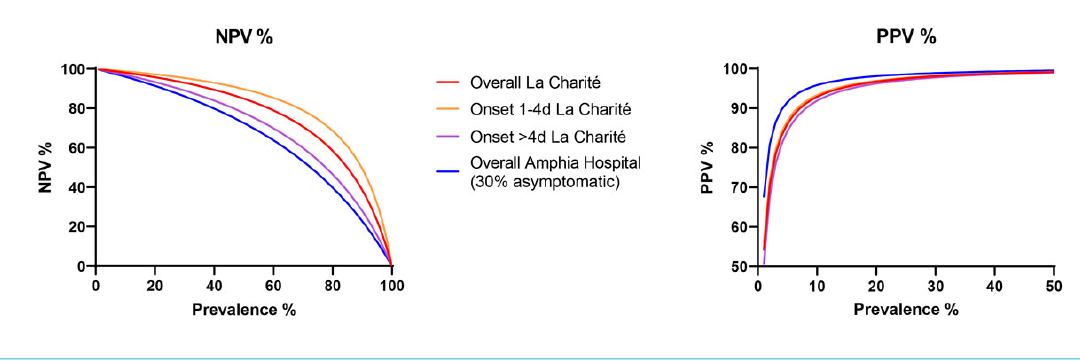
Figure 1: Positive and negative predictive value for prevalence of SARS-CoV-2 using the SD Biosensor rapid antigen test with self-swabbing by different tested populations.